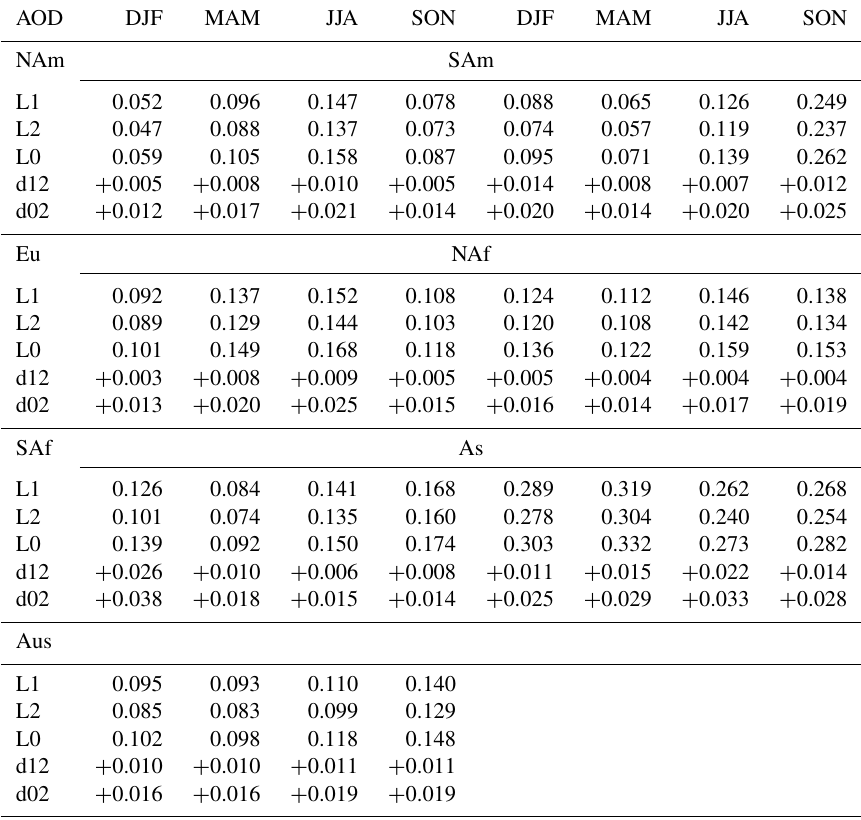
Table 1. Seasonal AOD based on sampling for different cloudiness. L1 and L2 refer to level 1 and level 2 of AERONET data, respectively. L0 refers to those cases of L1, which did not belong to L2, thus cloudy cases only. Different regions have the following abbreviations: NAm (North America), SAm (South America), Eu (Europe), NAf (northern Africa), SAf (southern Africa), As (Asia), Aus (Australasia). These regions are indicated by the solid lines in Fig. 2.